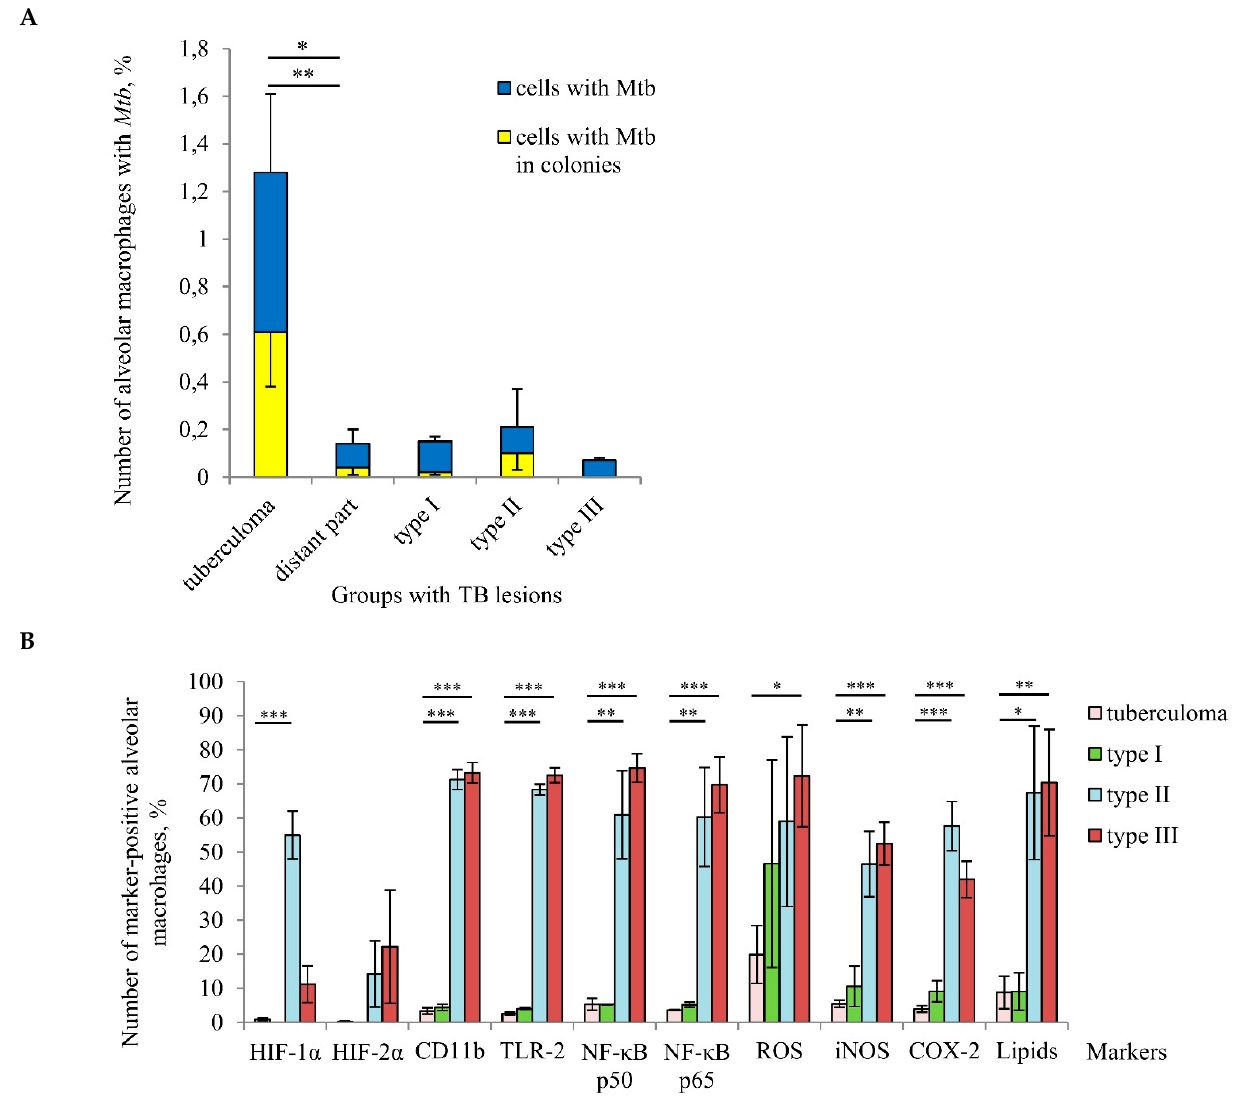
Figure 5. A tuberculoma wall with the lack of antimicrobial activity of alveolar macrophages is the main niche for Mtb survival (single or as colonies) in host cells among different TB patients’ lung lesions examined. ( A ) The number of alveolar macrophages with any Mtb (single or as colonies) and with Mtb in colonies, some with cording morphology, both expressed as the percentage of the total number of alveolar macrophages. ( B ) The number of alveolar macrophages with the markers expressed as the percentage of the total number of the TB patients’ alveolar macrophages analyzed. ( A , B ) The TB lesions examined are the tuberculoma walls (“tuberculoma” group) and the lung tissues distant from tuberculomas (“distant part” group) of all TB patients studied, and, differentially, the lung tissues with extensive, focal, and minimal fibrosis (“type I”, “type II”, and “type III” groups, respectively) distant from tuberculomas of TB patients 22–23, 24–26, and 27–29, respectively. Data are expressed as the means ± SEM. ( A ) * p ˂ 0.05 (comparing alveolar macrophages with Mtb in colonies), ** p < 0.01 (comparing alveolar macrophages with Mtb ), Student’s t -test. ( B ) * p ˂ 0.05, ** p < 0.01, *** p < 0.001, Student’s t -test.